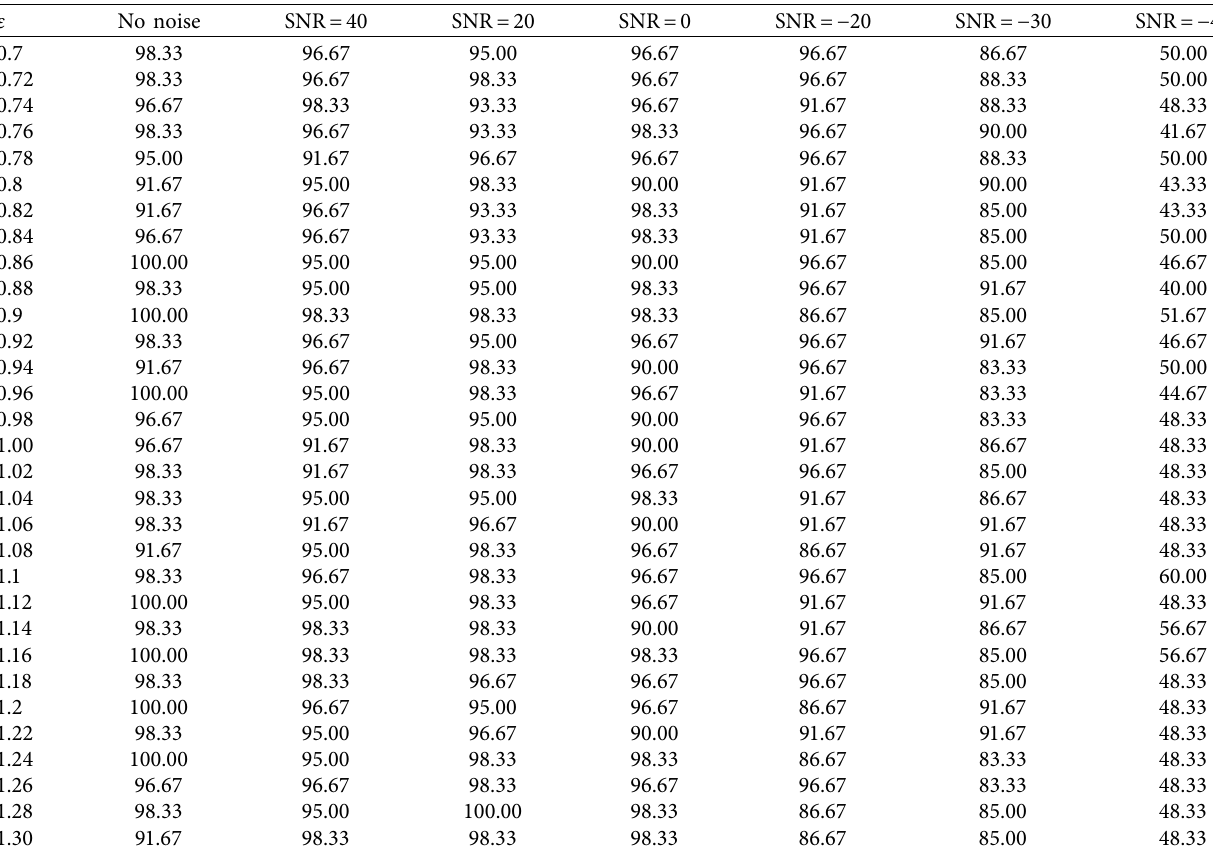
Table 1: Correct recognition rate of test data under different noise levels and distance coefficients